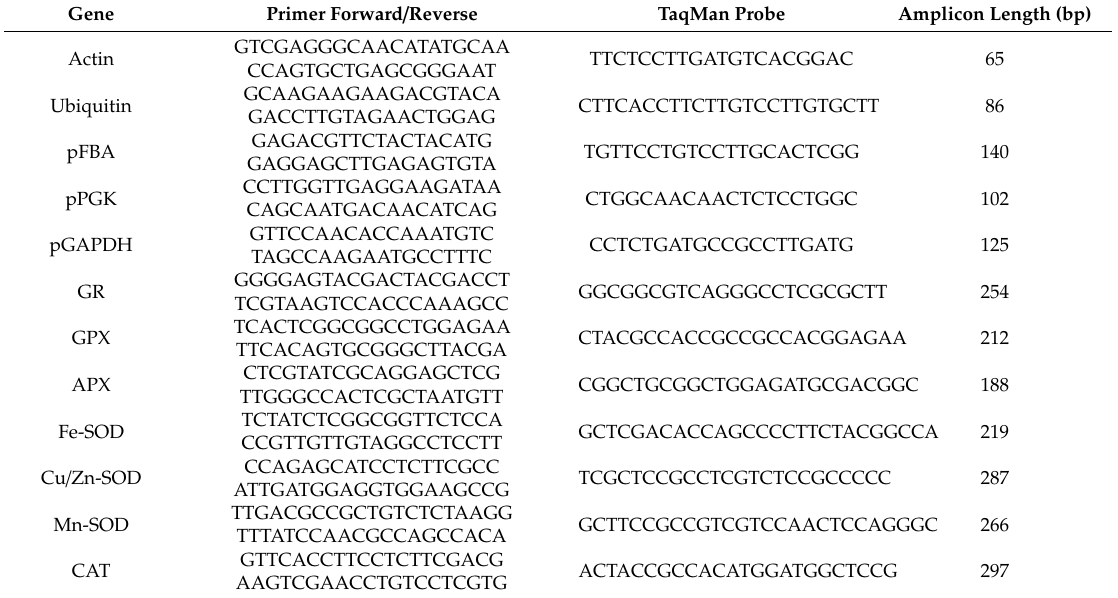
Table 2. Primers, probe sequences, and amplicon lengths of reference and target genes used for RT-qPCR